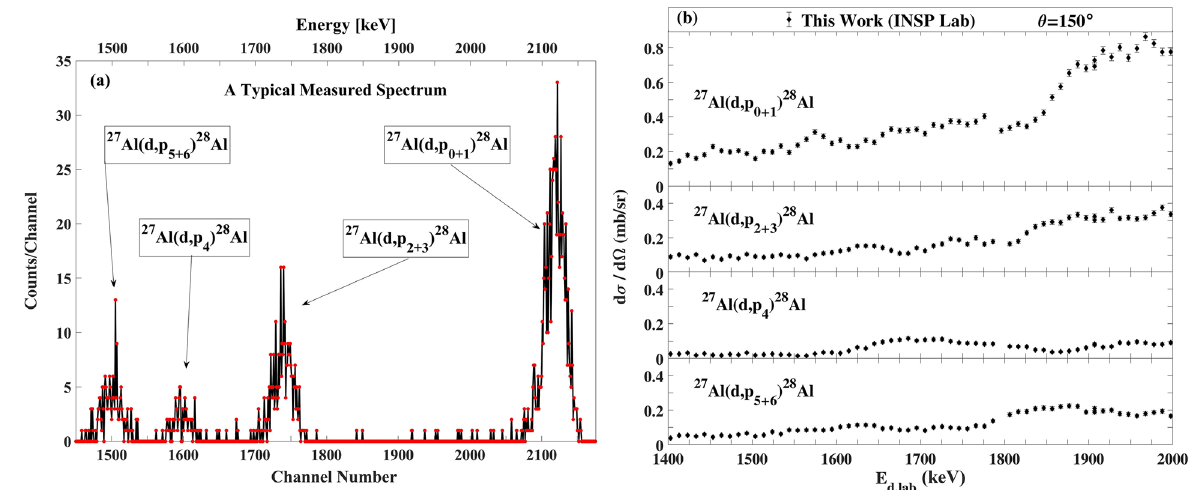
Figure 9. ( a ) A typical spectrum of protons for the 27 Al(d,p) 28 Al reaction. ( b ) The excitation functions for the 27 Al(d,p) 28 Al reaction at scattering angle 150° at INSP Lab in Paris. Where not visible, the estimated uncertainties from counting statistics are smaller than the plotted symbols.